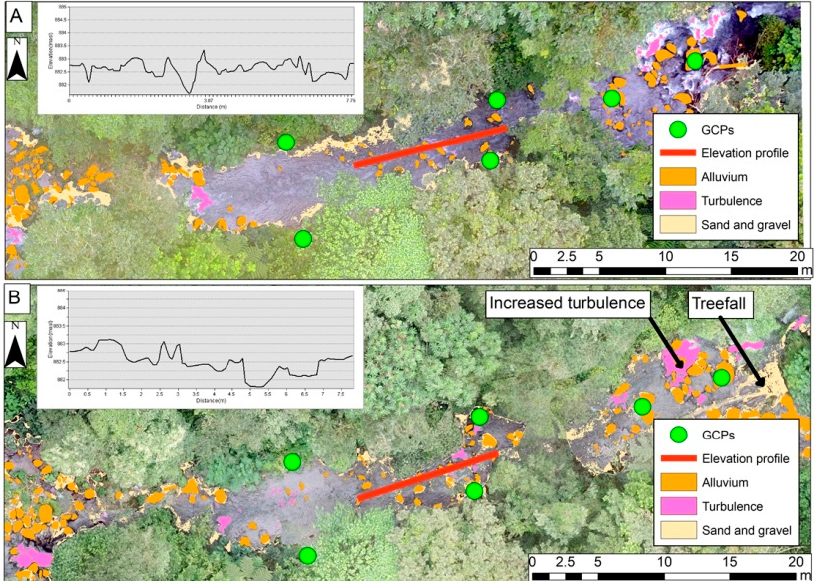
Figure 7. Monitoring high-resolution changes in the San Lorencito River. The analysis of both surveys allowed the detection of slight and detailed channel changes; the elevation profile shows how several boulders have been transported during the observation period. ( A ) first observation 14 8 2017 and ( B ) second observation 21 September 2017.